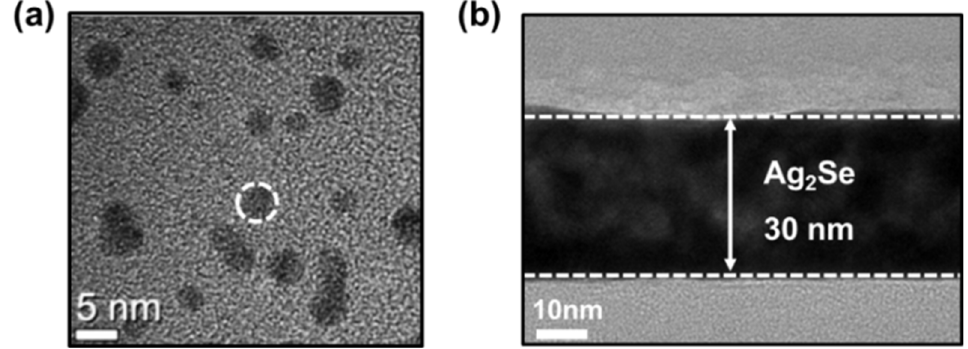
Figure 3. TEM images of the Ag 2 Se NPs ( a ) and cross-sectional image ( b ) of the Ag 2 Se NP thin film.